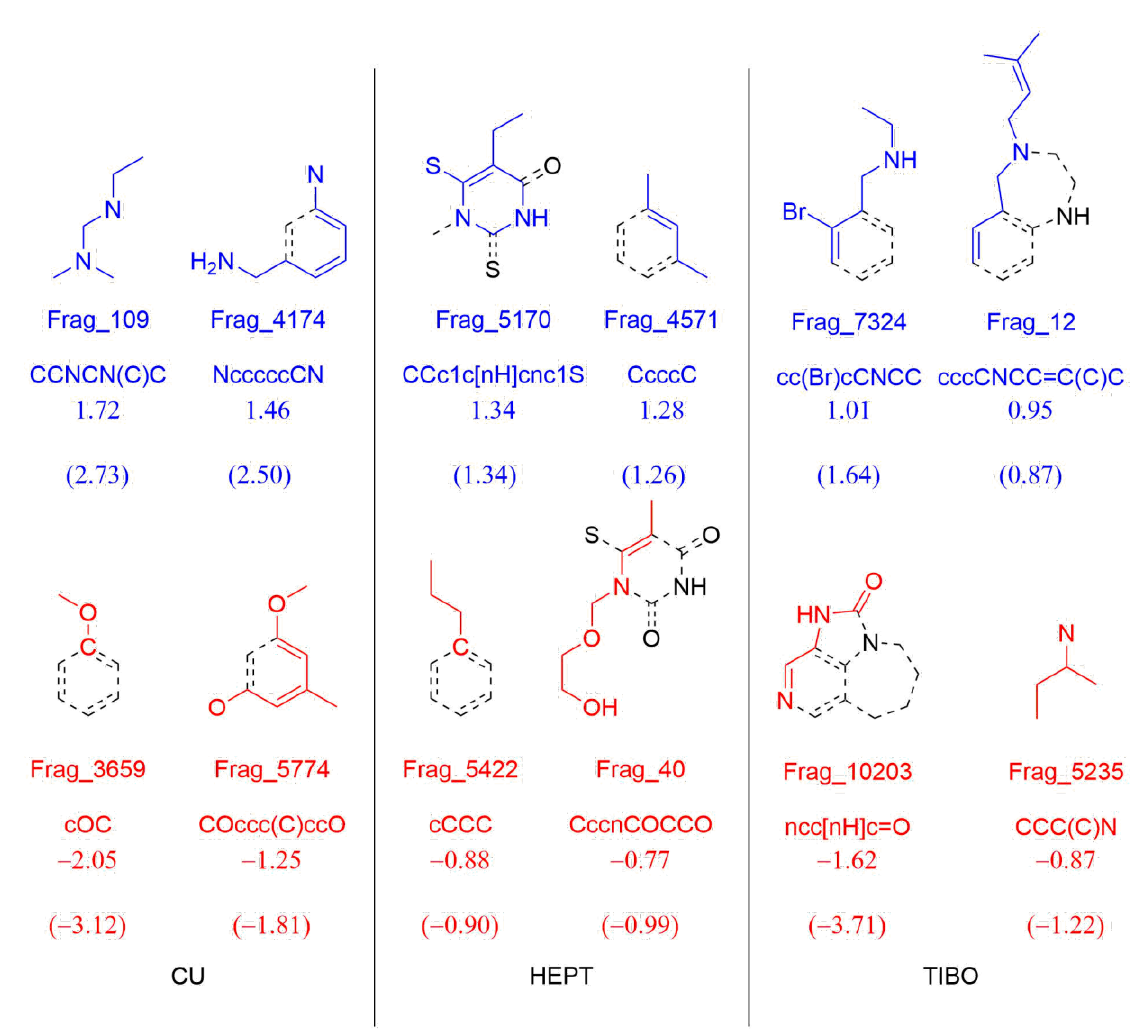
Figure 12. Main molecular fragments (MFs) retrieved by the LASSO model for anti-HIV activity. The red-colored fragments have negative values and increase the log(1/IC 50 )) endpoint. The blue MFs have positive values and decrease the log(1/IC 50 )) endpoint. Below, each MF there is its name, SMILES notation, LASSO coefficient, and the multilinear coefficient, in